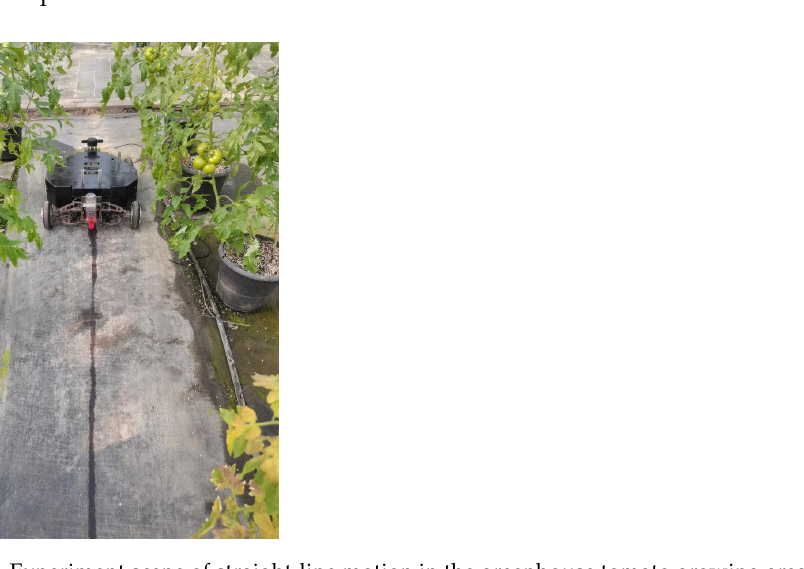
Figure 22. Experiment scene of straight-line motion in the greenhouse tomato growing area.